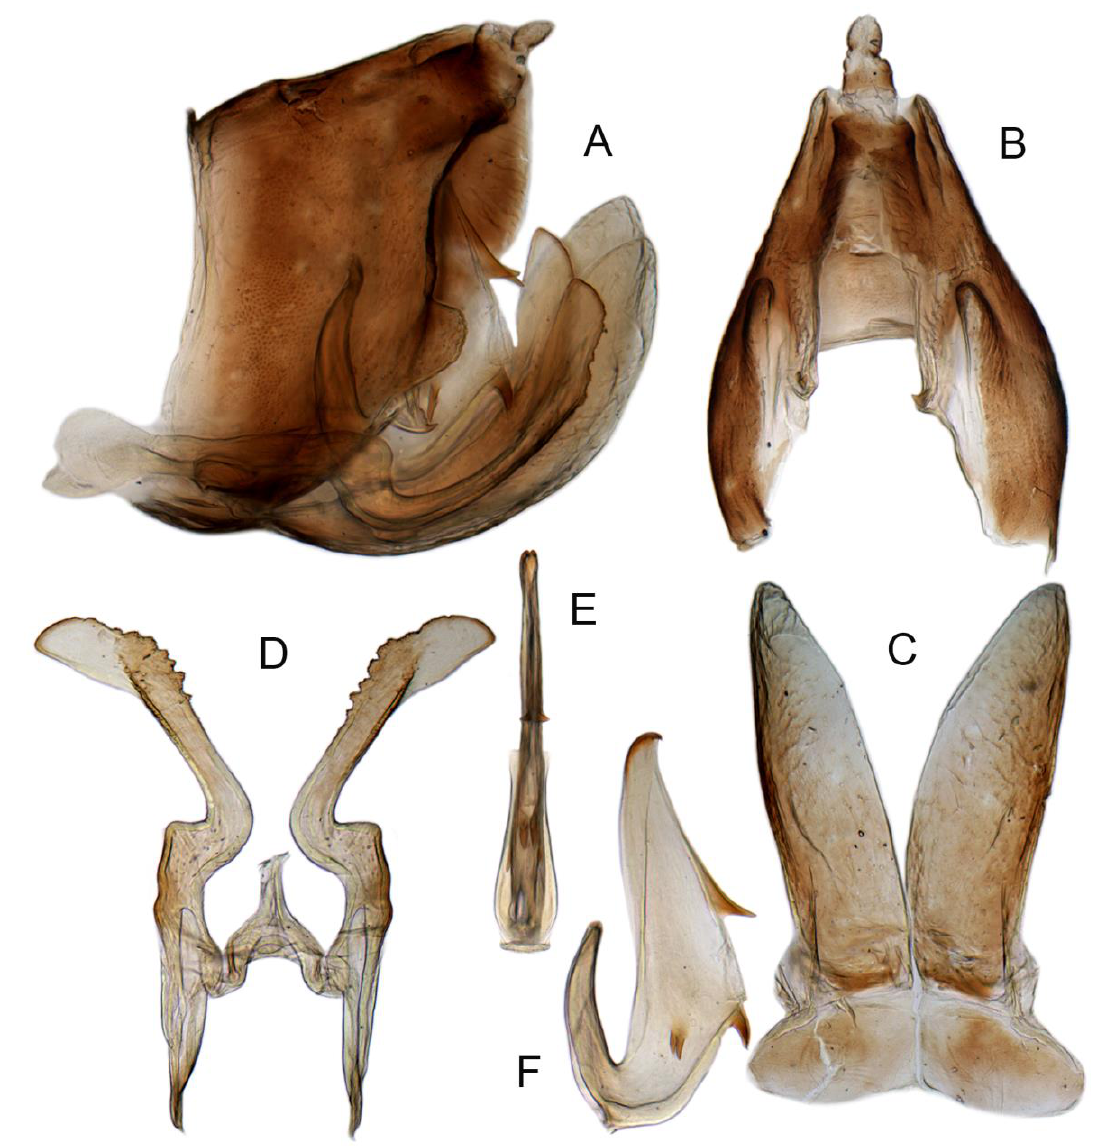
Figure 15. ( A – F ) Planaphrodes baoxingensis sp. nov. ( A ) pygofer, lateral view. ( B ) genital capsule, ventral view. ( C ) subgenital plates, ventral view. ( D ) stylets and connective, ventral view. ( E ) aedeagus, ventral view. ( F ) aedeagus, lateral view.